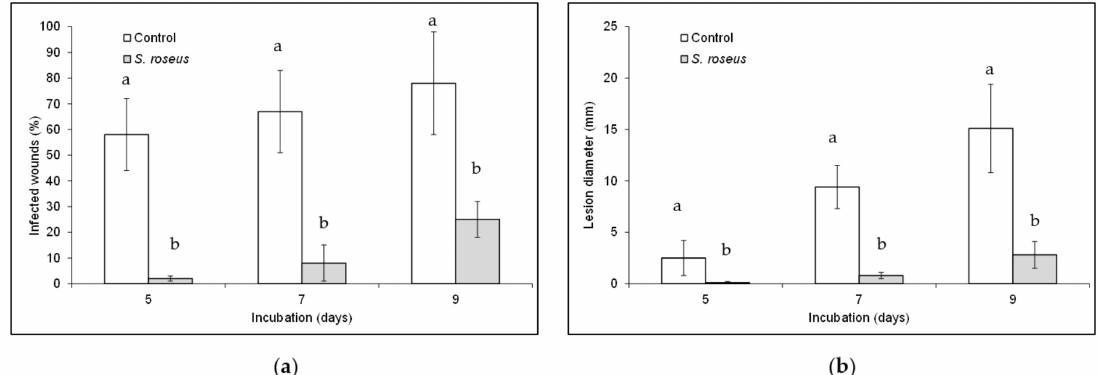
Figure 3. Sporobolomyces roseus effect on blue mold incidence ( a ) and severity ( b ) on Golden Delicious apples. Fruit were wounded, yeast-treated, pathogen-inoculated, and stored at 20 ± 1 ◦ C for 9 days in the dark and high relative humidity. Data are the mean of three replicates ± standard error of the mean (SEM). Bars with different letters are statistically significant ( p ≤ 0.05) according to Duncan’s Multiple Range Test (DMRT).